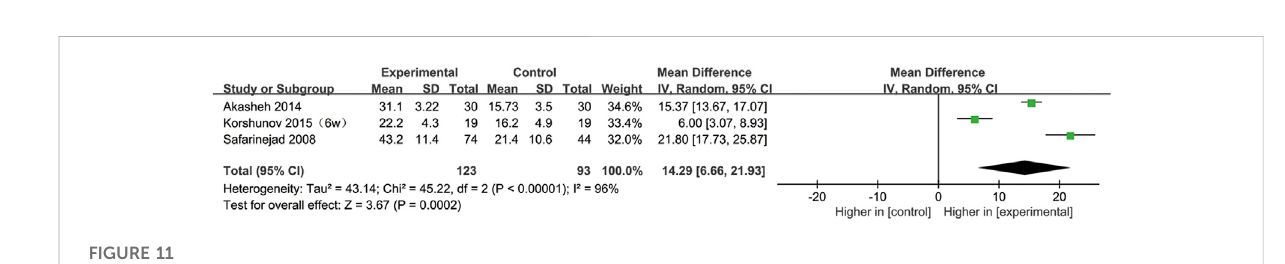
Forest plot for the association between SSRIs used and sperm